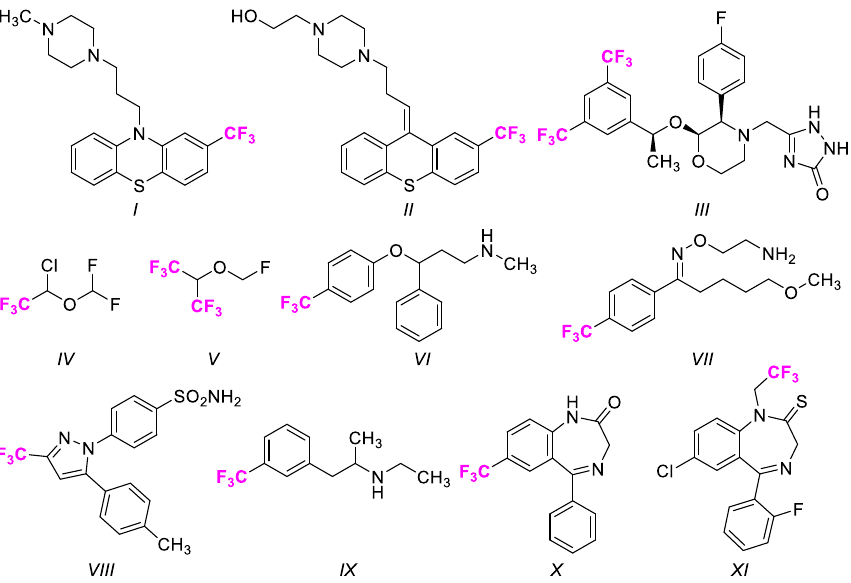
Figure 1. Examples of trifluoromethyl motif containing CNS-acting drugs.